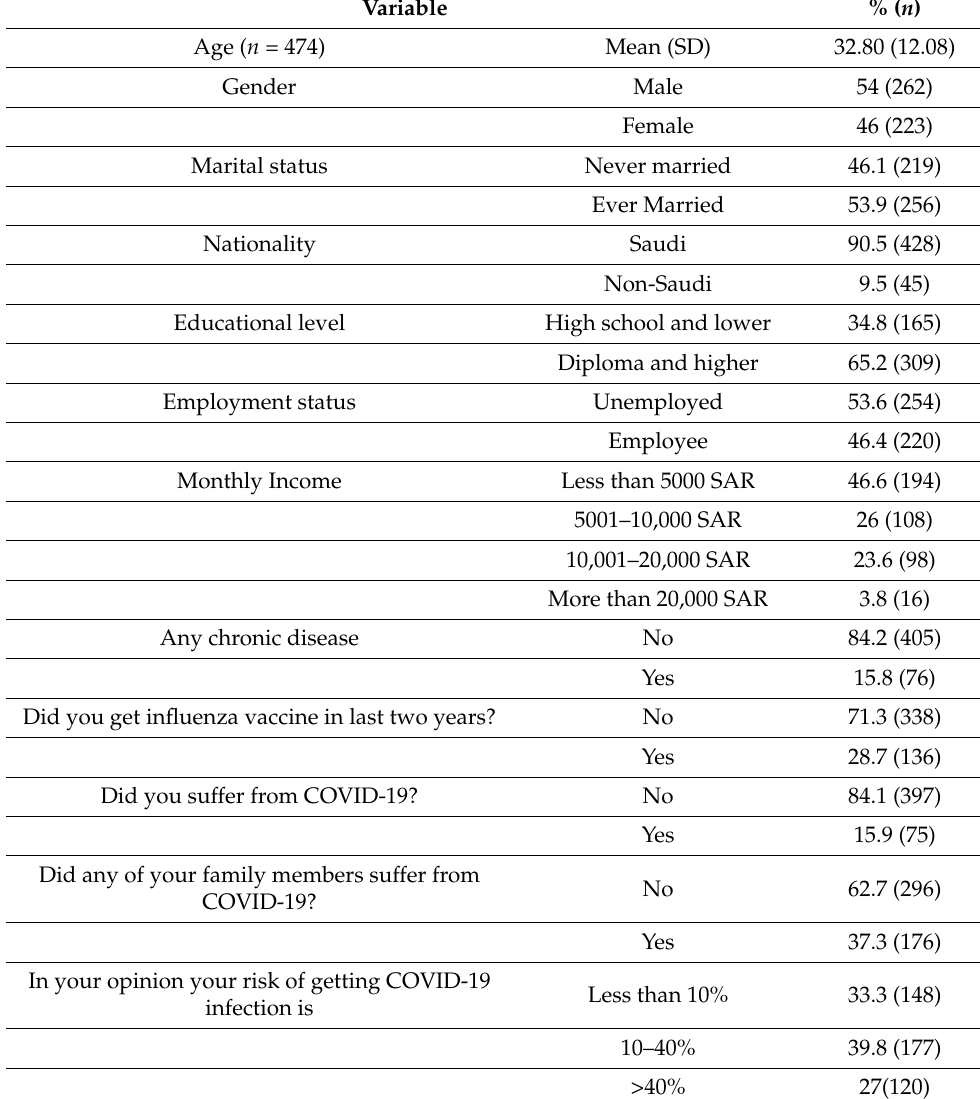
Table 1. Socio-demographic and health characteristics of the study population ( n =